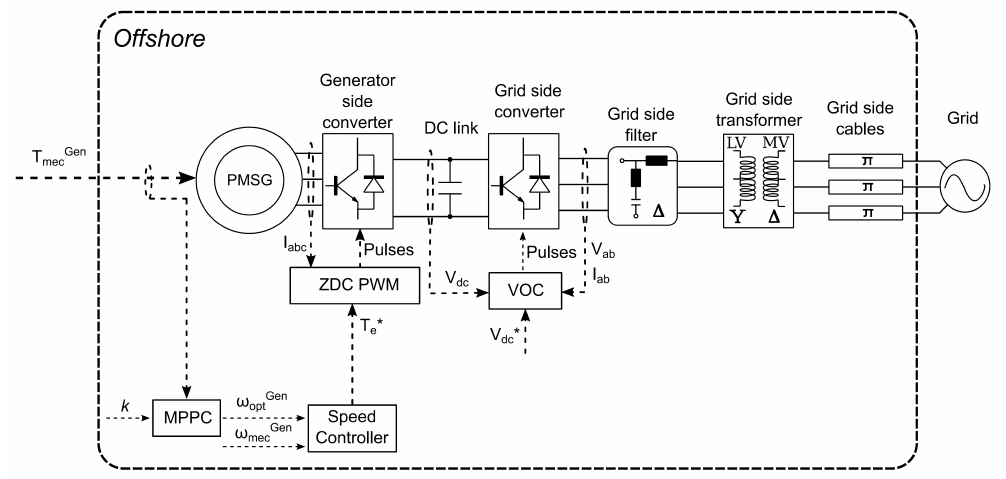
Figure 2. Block diagram of the electrical model of the tidal system, after